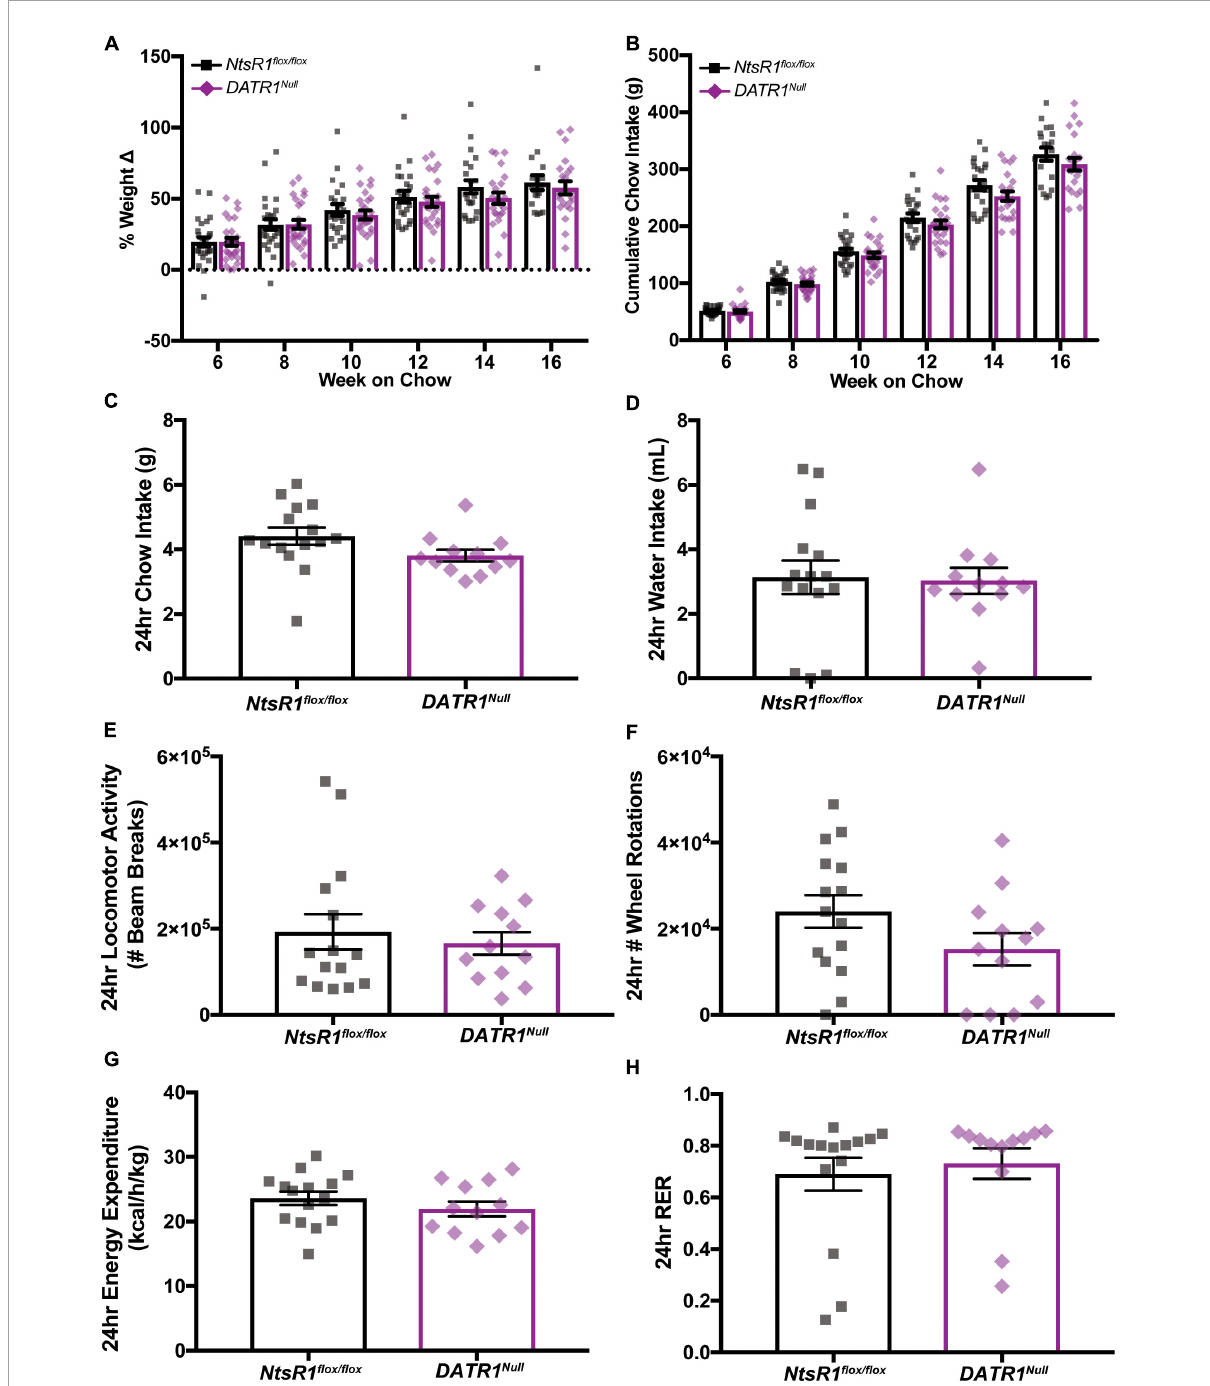
FIGURE2 Developmental deletion of NtsR1 from DA neurons has no impact on body weight. (A,B) Chow fed NtsR1 flox / flox (Controls with intact NtsR1) and DATR1 Null mice (with developmental NtsR1 deletion from DA neurons) were individually housed at 4 weeks old and analyzed in home cages. Body and chow weight was measured weekly for 12 weeks. (A) % weight change every 2 weeks from week 6 to 16. (B) Cumulative chow intake every 2 weeks from week 6 to 16. Both NtsR1 flox / flox and DATR1 Null mice gain weight and consume chow indistinctly from each other. Data represent mean ± SEM analyzed via ordinary 2Way-ANOVA with Sidak’s correction. n = 12–13. (C–H) Chow fed NtsR1 flox / flox and DATR1 Null mice were analyzed in metabolic cages. Data was pooled for a ∼ 24 h period that contains a light and dark cycle. Developmental deletion of NtsR1 from DA neurons did not alter (C) chow intake, (D) water intake, (E) ambulatory locomotor activity, (F) number of wheel rotations, (G) energy expenditure or (H) respiratory exchange ratio (RER). Data represent mean ± SEM. Body weight was analyzed with two-tailed unpaired t -test ( n =